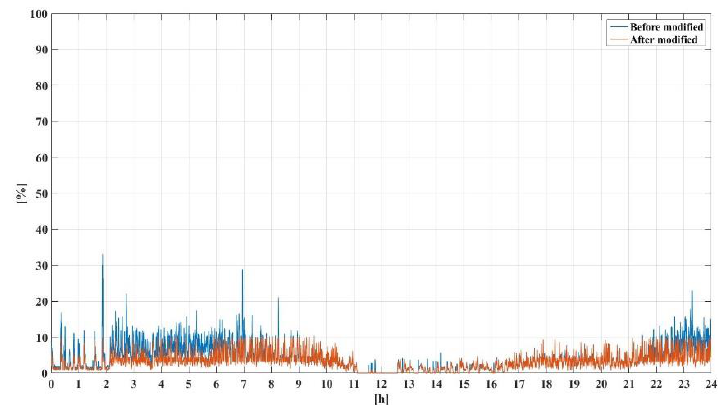
Figure 26. Simulation results: fluctuation rate per minute after and before modification.